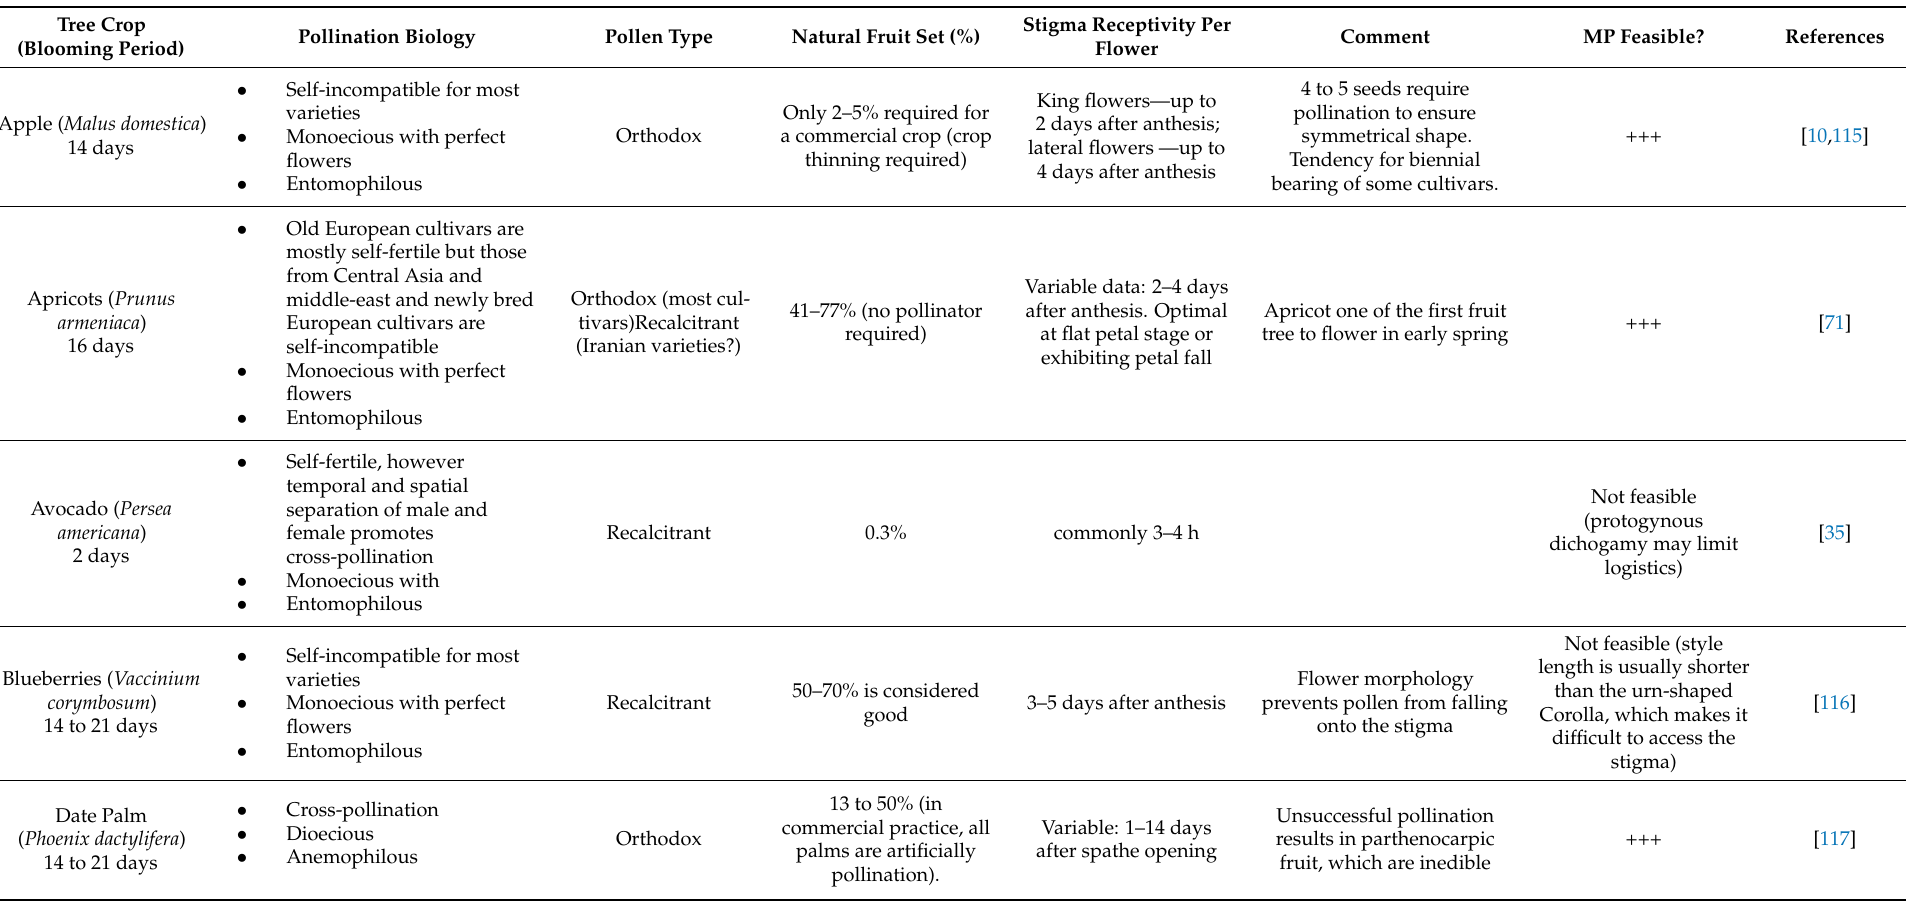
Table 4. Pollination biology of selected fruit and nut crops. Feasibility of mechanical pollination (MP) for each crop is rated as highly feasible (commercial reality, +++), feasible (some evidence available, ++), theoretically feasible (+), or not